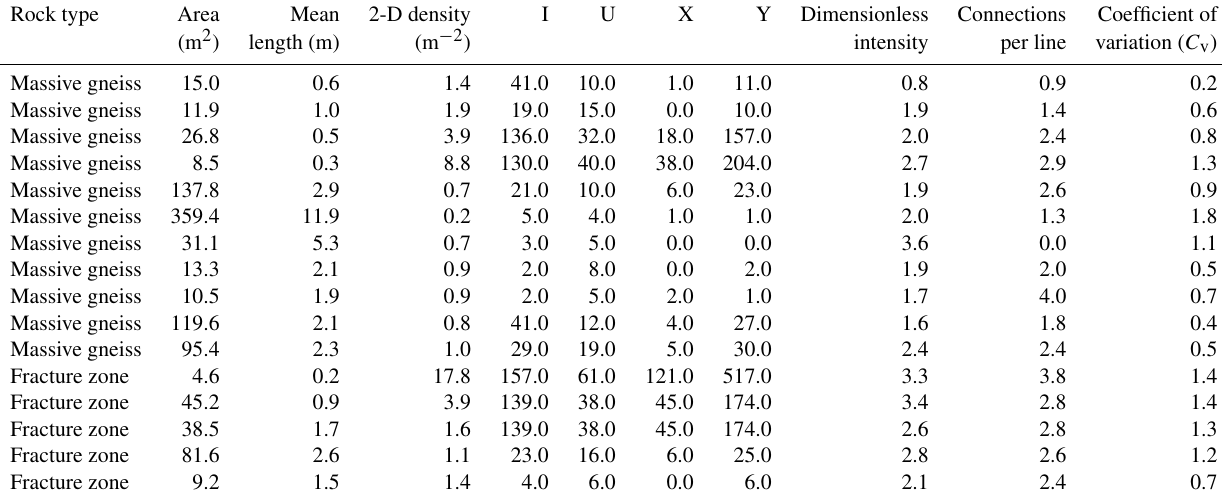
Table 1. Summary fracture network statistics from the Peninsular Gneiss in the Cauvery Catchment, southern India. Rock